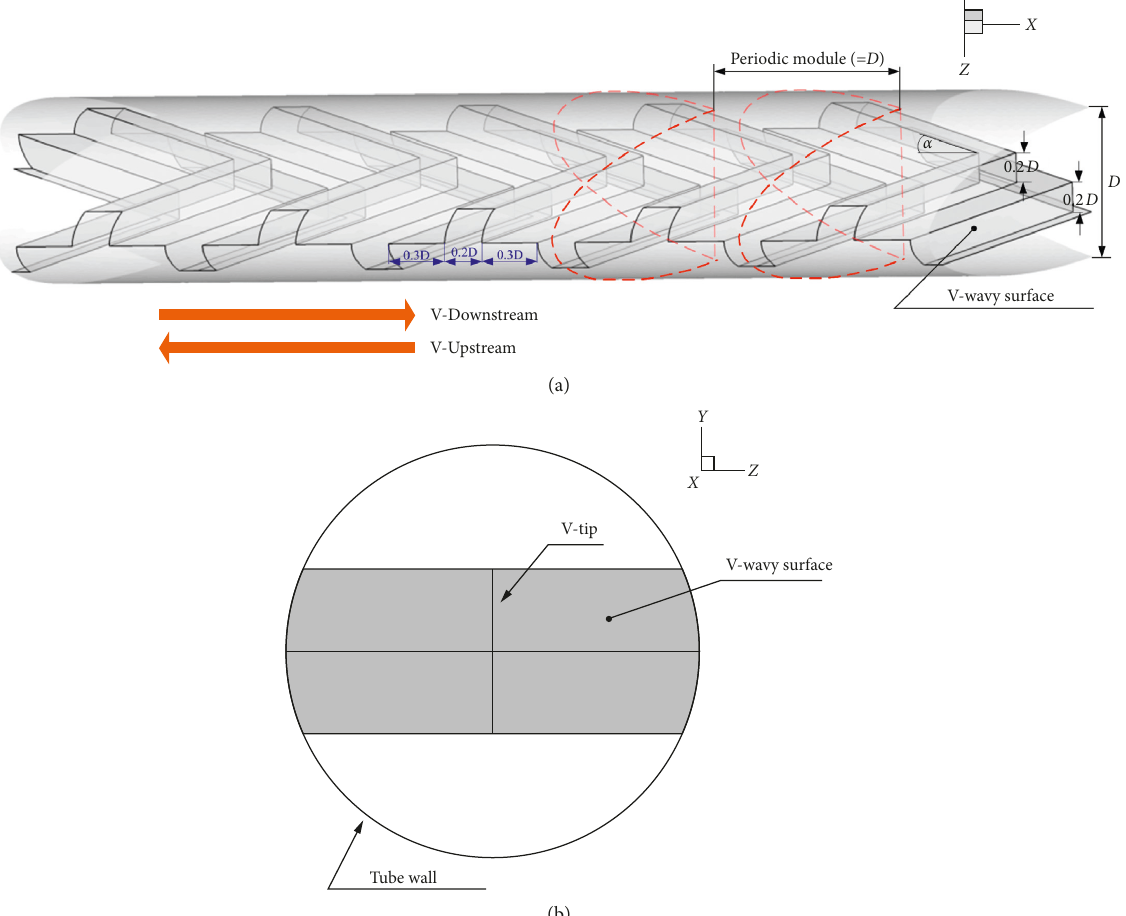
Figure 1: (a) Physical model of the heat exchanger tube inserted with the V-wavy surface and (b) tube geometry in the transverse